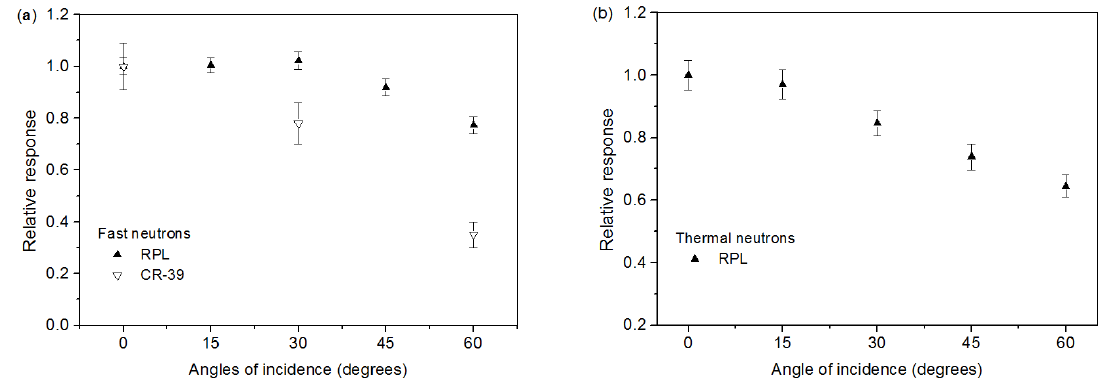
Figure 6. Angular variations of the RPL and CR-39 detectors: ( a ) fast neutrons ; ( b ) thermal neutrons.